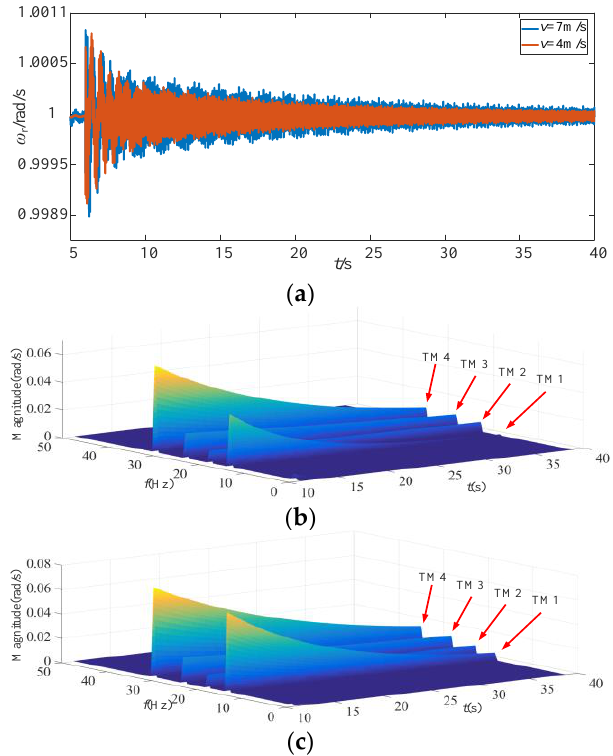
Figure 12. Rotor speed response of SG and the time–frequency analysis result: ( a ) rotor speed response curve; ( b ) v = 4 m/s; ( c ) v = 7 m/s.